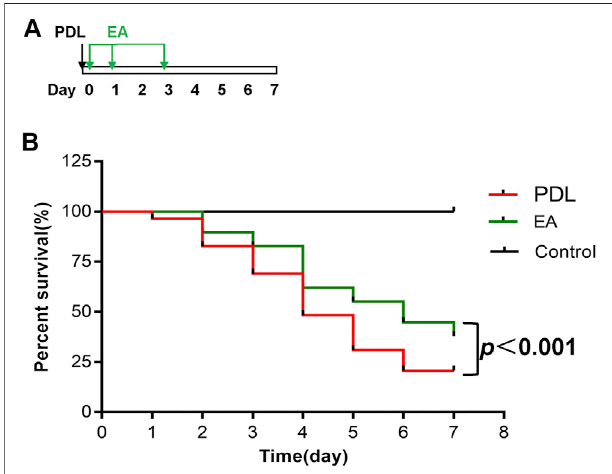
FIGURE 7 | EA prolongs survival of mice with PDL-induced pancreatitis. (A) Schematic description of time line. (B) The Kaplan – Meier curve presents the survival rate, n (cid:1) 29. PDL, pancreatic duct ligation; EA,